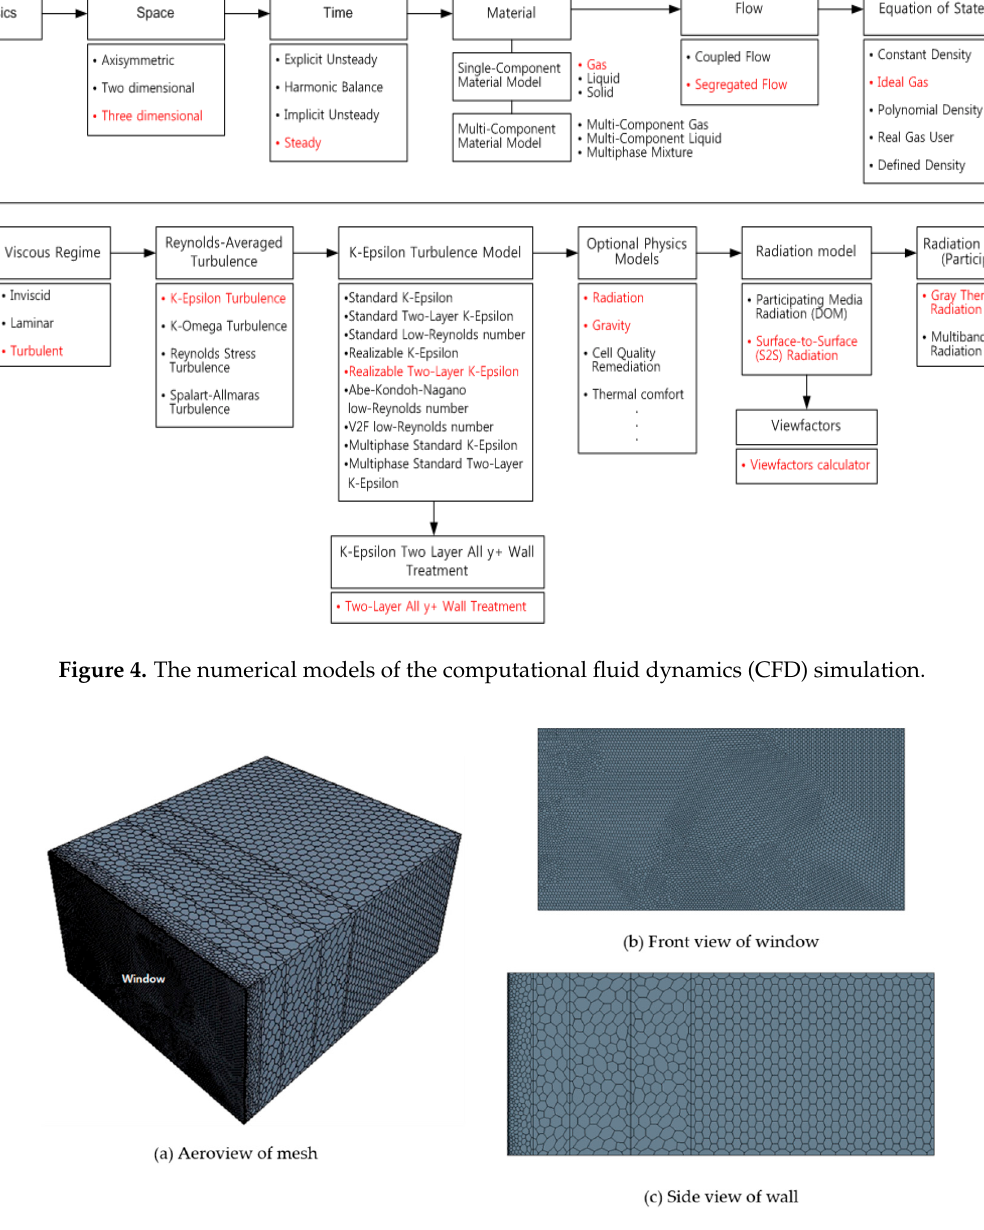
Figure 5. Generation of mesh model.